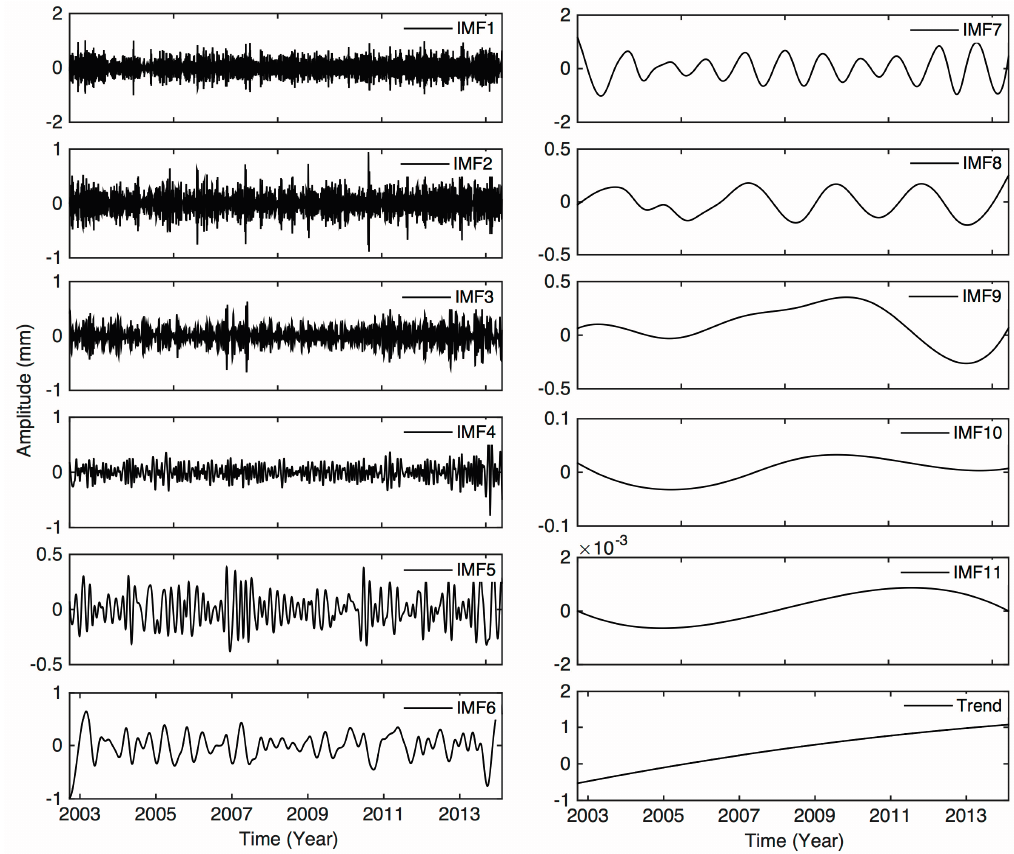
Figure 4. The signals corresponding to IMF1 to IMF11, and a long-term trend, from the GPS vertical time series at station LHAZ, Tibet.